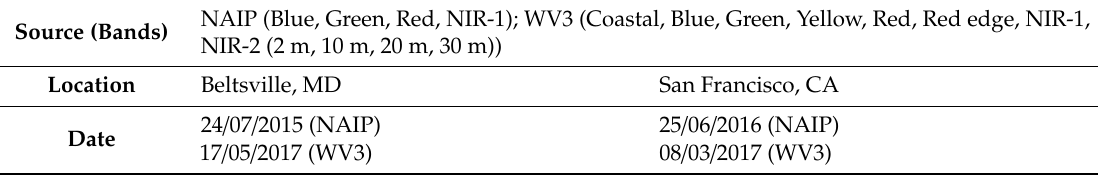
Table 1. The source, location, and dates of remotely sensed data used in the